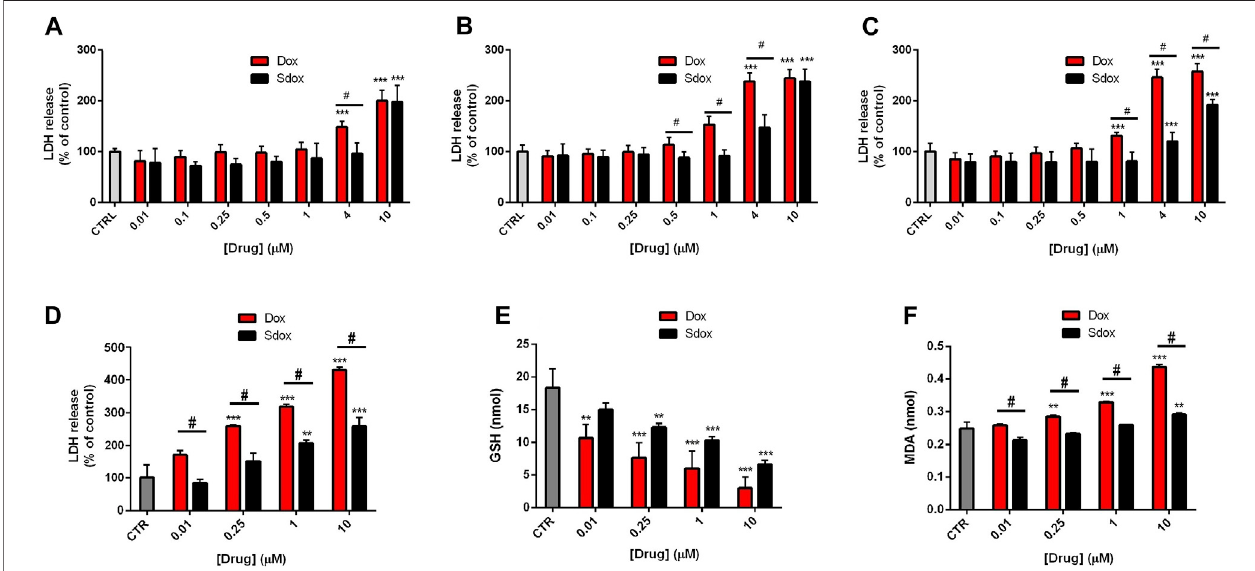
FIGURE 5 | Effectsof Sdox and Dox treatment on HepG2 cells and primary rat hepatocytes. LDH release after (A) 24 h, (B) 48 h, and (C) 72 h treatment with Dox and Sdox inHepG2 cells. (D) LDH release and oxidative stressestimated bymeasuring (E) reducedGSH and (F) MDA inprimaryrat hepatocytes.Dataaremeans ±SD of triplicate assays ( n = 3). * p < 0.05; ** p < 0.01; *** p < 0.001 vs. controls, one-way ANOVA with Dunnett ’ s post-test. # p < 0.05 vs. Dox, multiple t -test, corrected by the Holm – Sidak method.